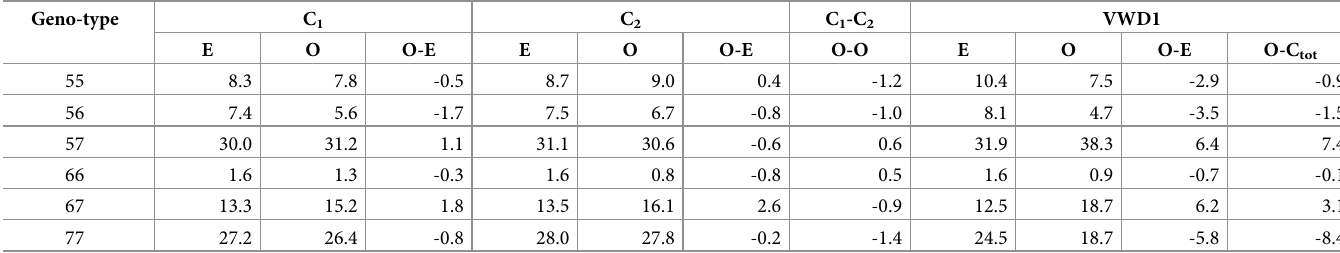
Table 4. Expected and observed genotype frequencies of the CLEC4M VNTR.